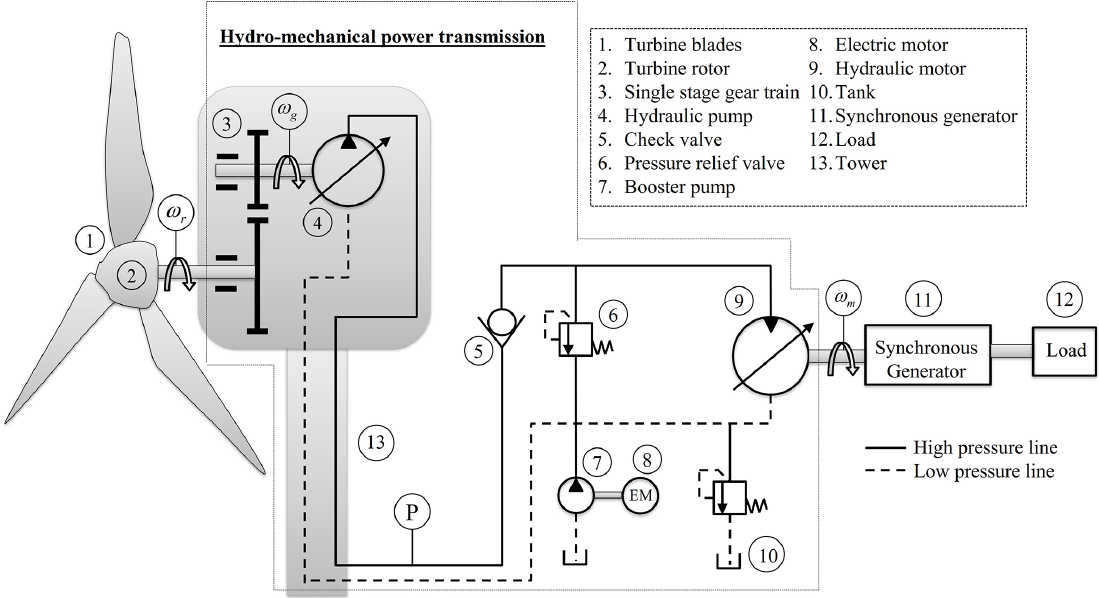
Figure 1. Outline of the proposed WTPGS.